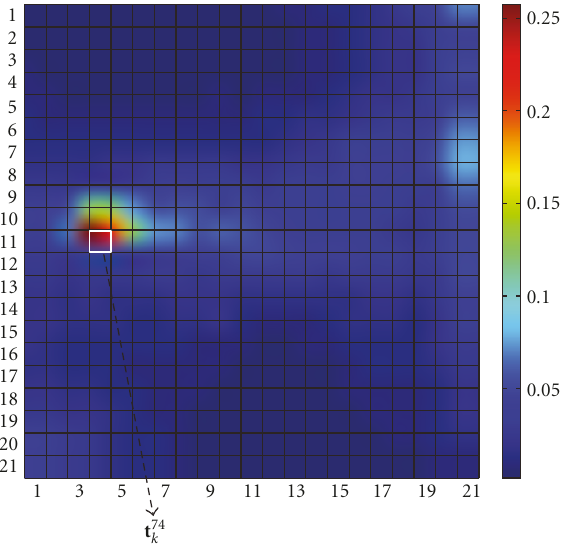
Figure 7: Weights of { t i mate p ( g k ).